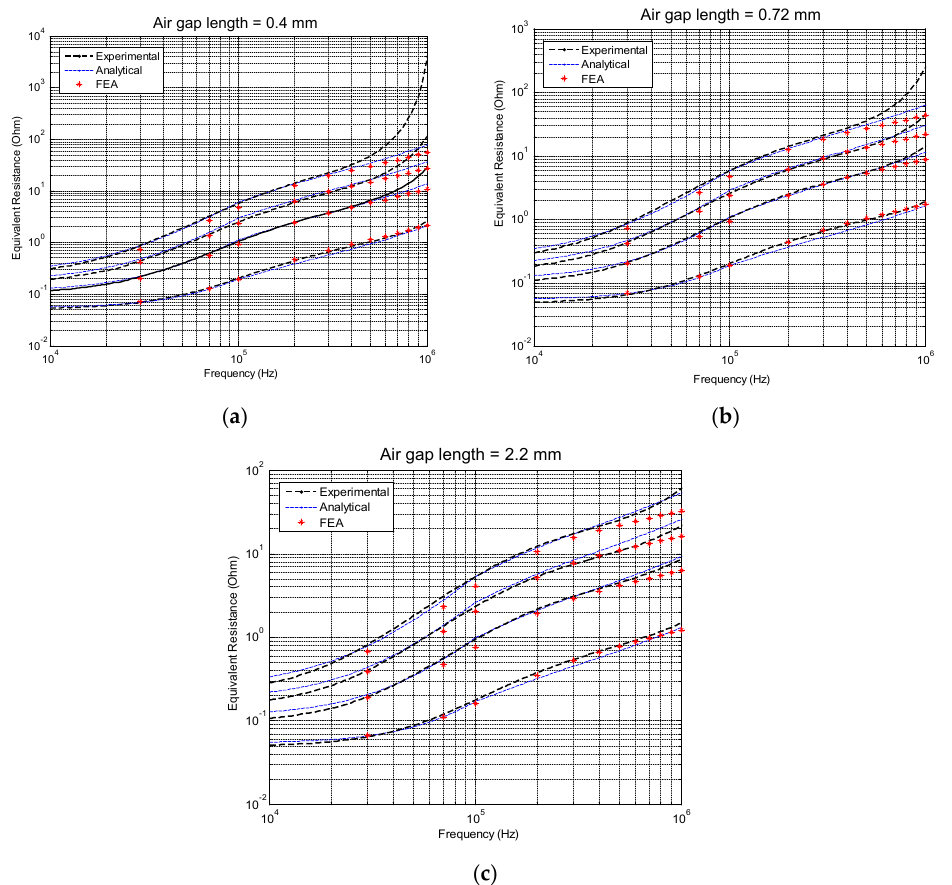
Figure 11. Comparison of the calculated results (analytical and FEA compensated with a calculated core resistance) with measurements for components with 1 to 4 layers (15 to 60 turns) with 0.4 mm, 0.72 mm, and 2.2 mm in ( a ), ( b ), and ( c ), respectively. The results were obtained by applying (12) and (8), and in all cases, the length of the considered turn was calculated according to its circumference. A copper conductivity of 45.249 × 10 6 S/m was used.